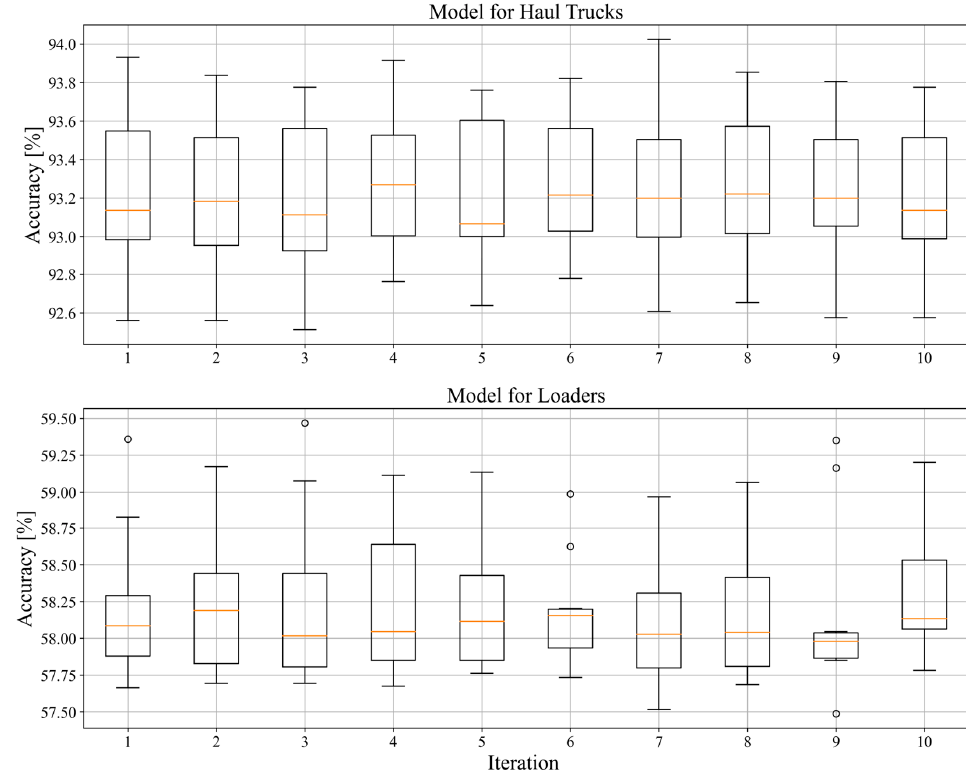
Figure 10. Results obtained from testing the stability of the models using the modified k-fold cross validation algorithm (Upper—network model for haul trucks, Lower—network model for loaders).